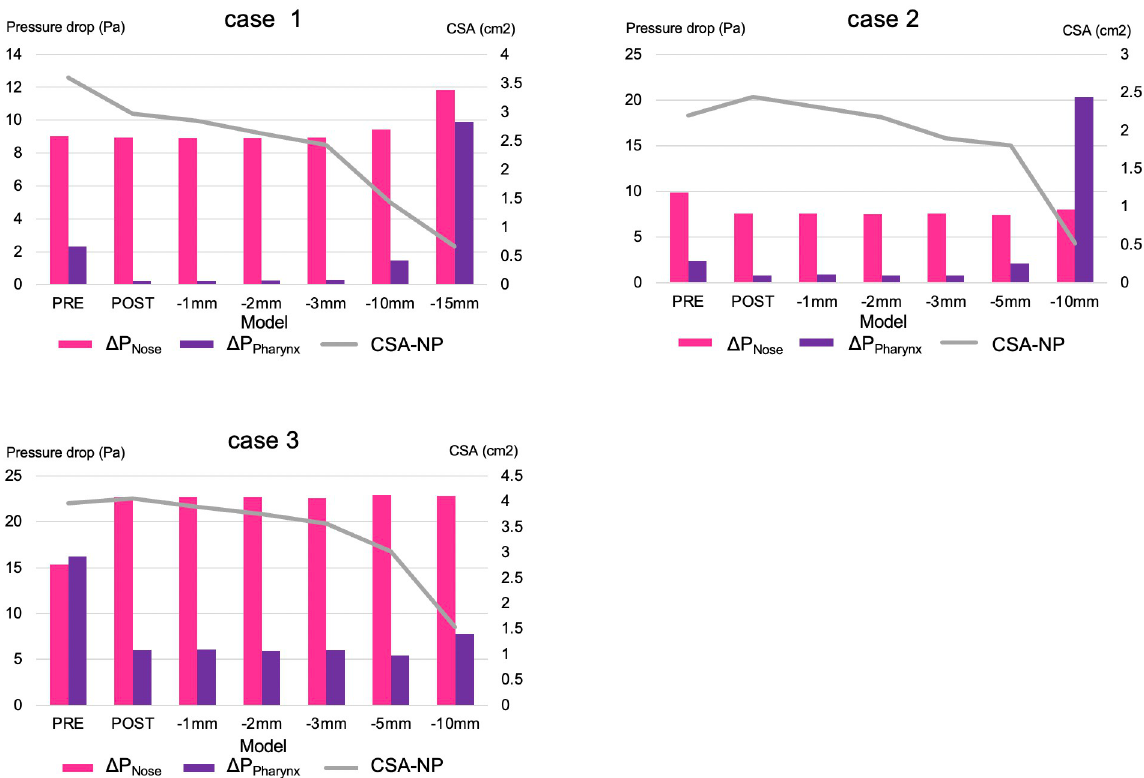
Fig 7. Pressure drop in the nasal cavity and nasopharynx. The line chart shows the CSA-NP. Abbreviations: -1 mm, STENOSIS -1 mm; -2 mm, STENOSIS -2 mm; -5 mm, STENOSIS -5 mm; -10 mm, STENOSIS -10 mm; -15 mm, STENOSIS -15 mm. Notes: pink bar, Δ P Nose ; purple bar, Δ P Pharynx ; gray line,